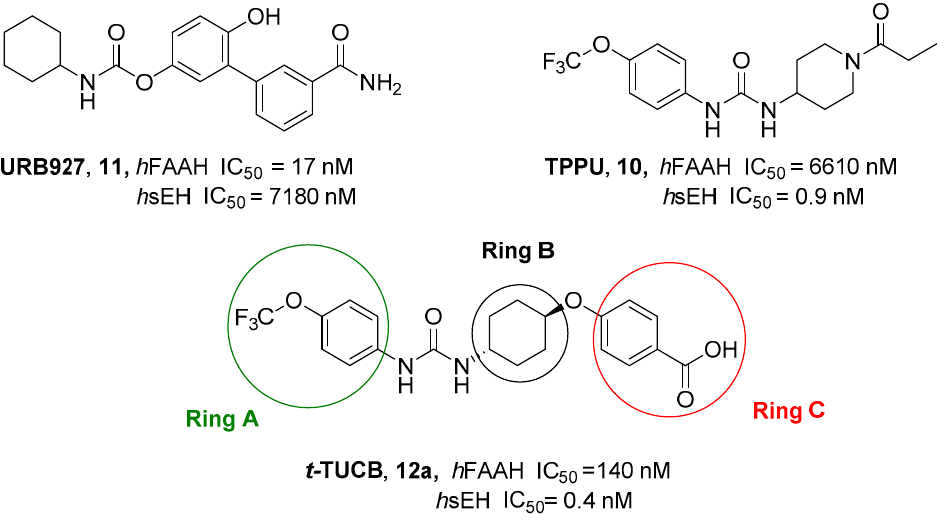
Figure 3. Chemical structures of the sEH inhibitors TPPU ( 10 ), FAAH inhibitor URB927 ( 11 ), t -TUCB ( 12a ) and marked rings A, B, and C in the t -TUCB skeleton. ( 12a ) and marked rings A, B, and C in the t -TUCB